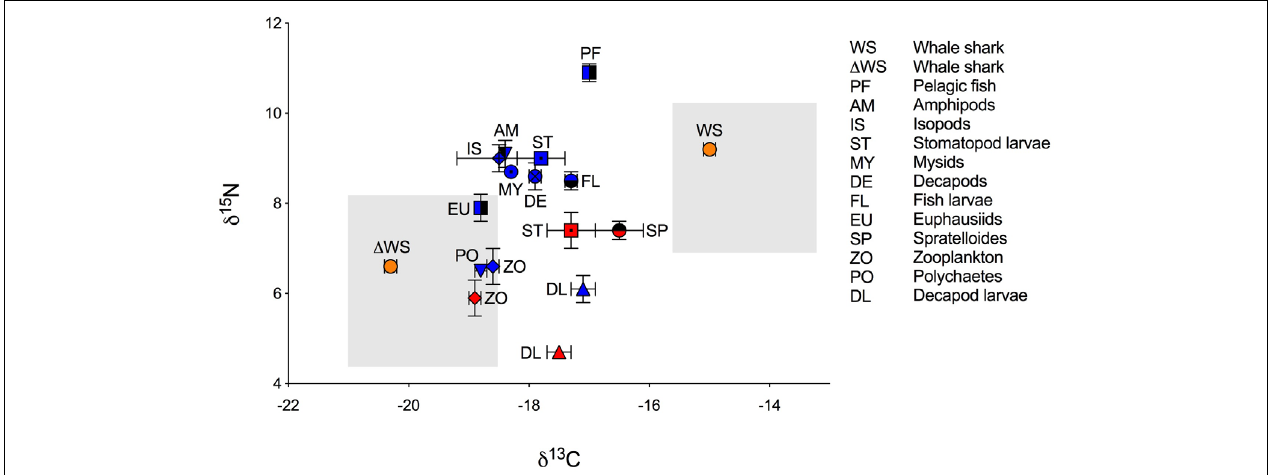
± standard error) of whale shark dermis (lipids extracted) and potential prey (lipid normalized) collected at Ningaloo FIGURE 1 | Biplot of mean isotopic values ( Reef in May 2013 and 2014. Mean isotopic composition of whale shark dermis is displayed for non-corrected values (WS) and for corrected values for isotopic (cid:104) discrimination ( (cid:49) WS) using diet-to-tissue discrimination factors of carbon and nitrogen ( (cid:49) 13 C and (cid:49) 15 N ) estimated in fin cartilage of captive whale sharks by Wyatt et al. (2019), ( (cid:49) 13 C = 5.3 and (cid:49) 15 N = 2.6). Potential prey is divided by years of sampling due to significant differences in the isotopic composition of some taxa between 2013 (red) and 2014 (blue). Shade areas indicate whale shark isospace for non-corrected and for corrected values for isotopic discrimination.